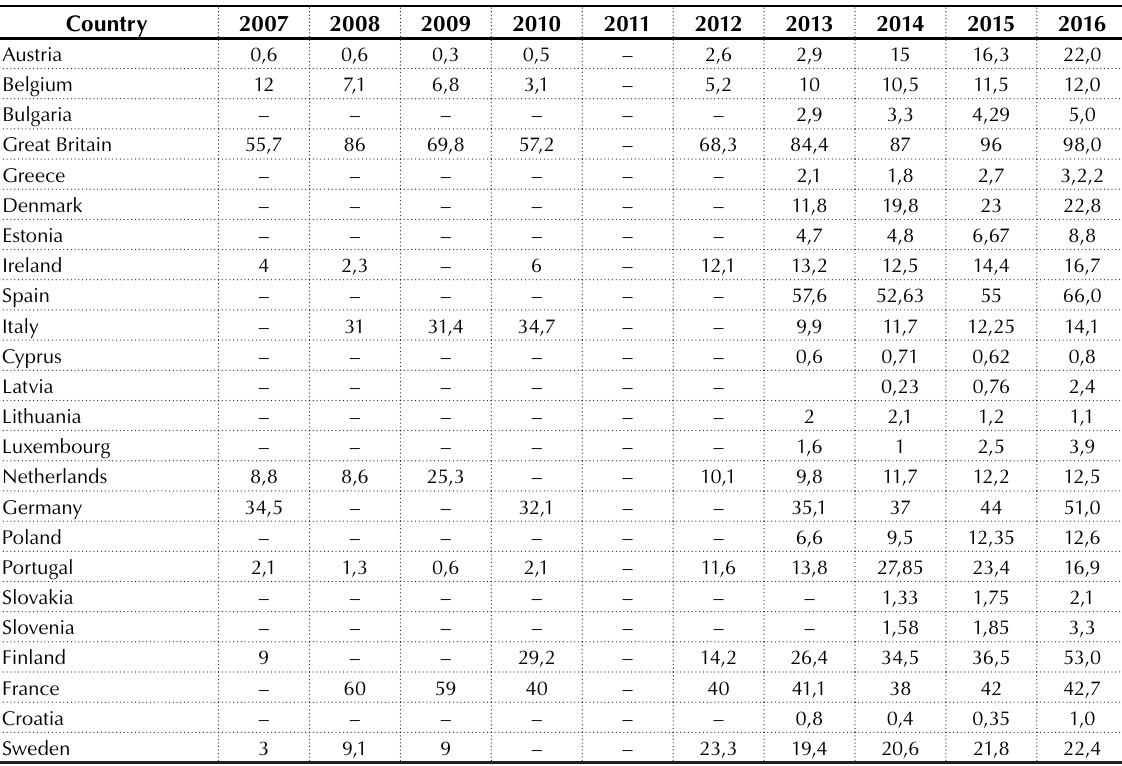
Table 3. Dynamics of business angel investments in EU countries for 2007–2016, mln euros Source: Compiled by authors based on EBAN (2015, 2016), OECD